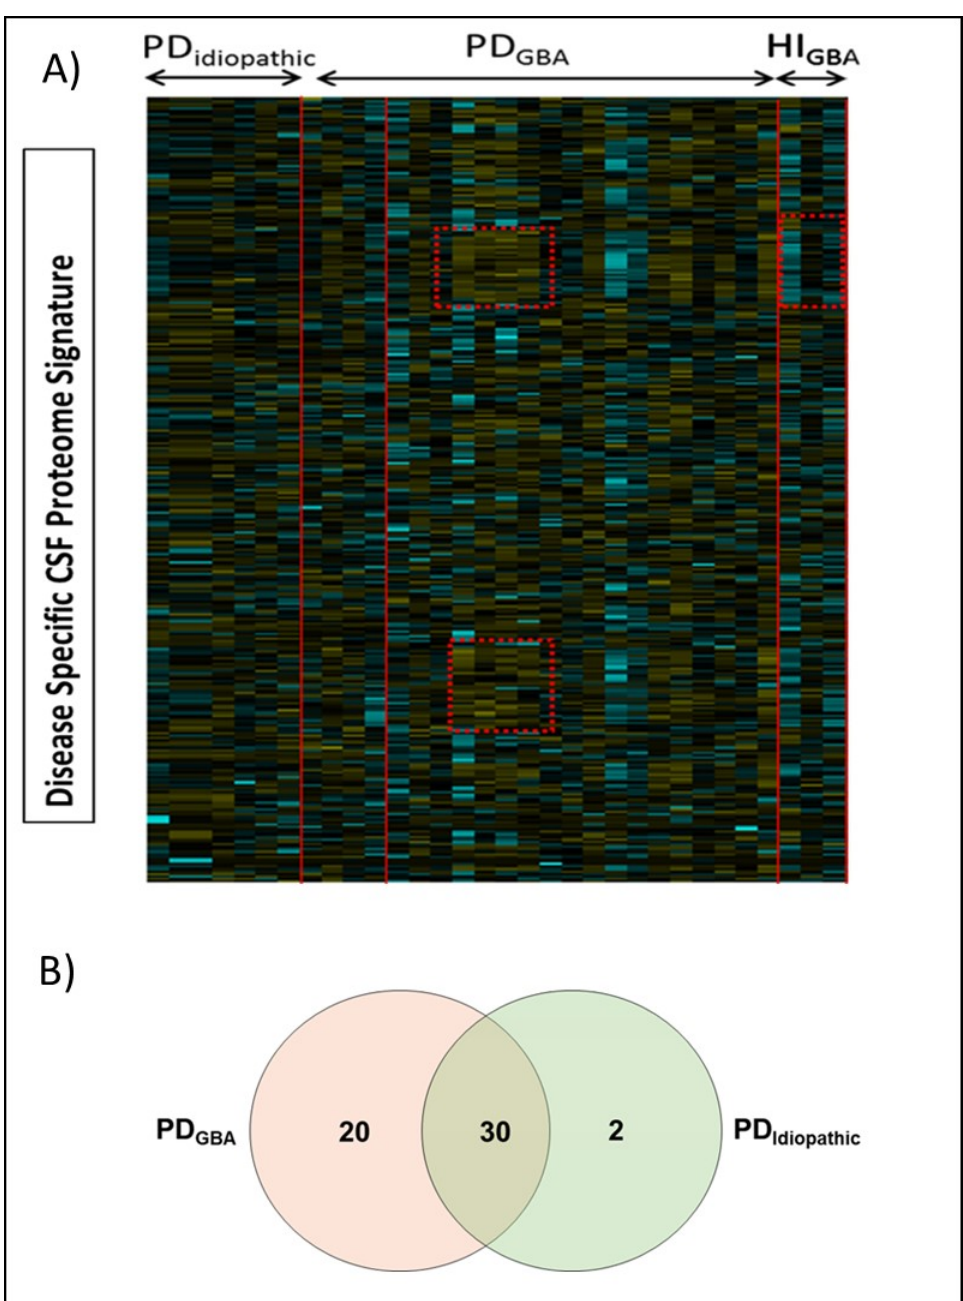
Figure 1 . Disease-specific alterations in CSF proteome. ( A ) The heat map shows the relative levels of identified proteins across all analyzed samples. The red lines mark clustering in response to GBA genotype in PD cases. Both rows and columns were clustered using correlation distance and average linkage and these clusters are represented by red lines ( B ) Venn diagram presenting the number and distribution of differentially regulated proteins of each group (in comparison to controls).